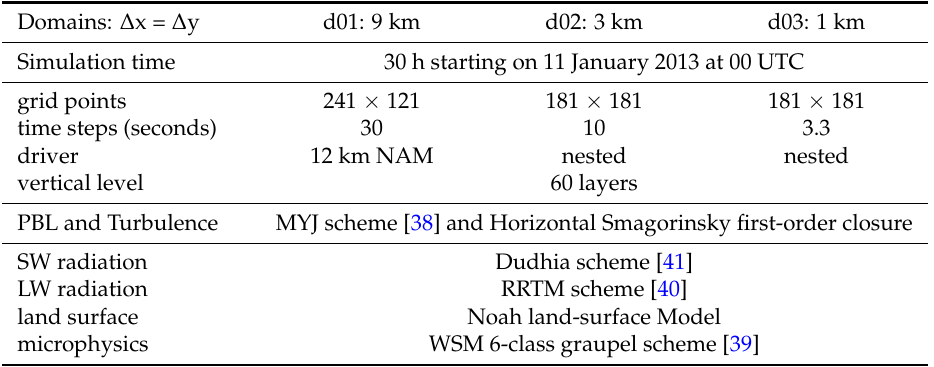
Table 1. WRF model configuration and domains used in this